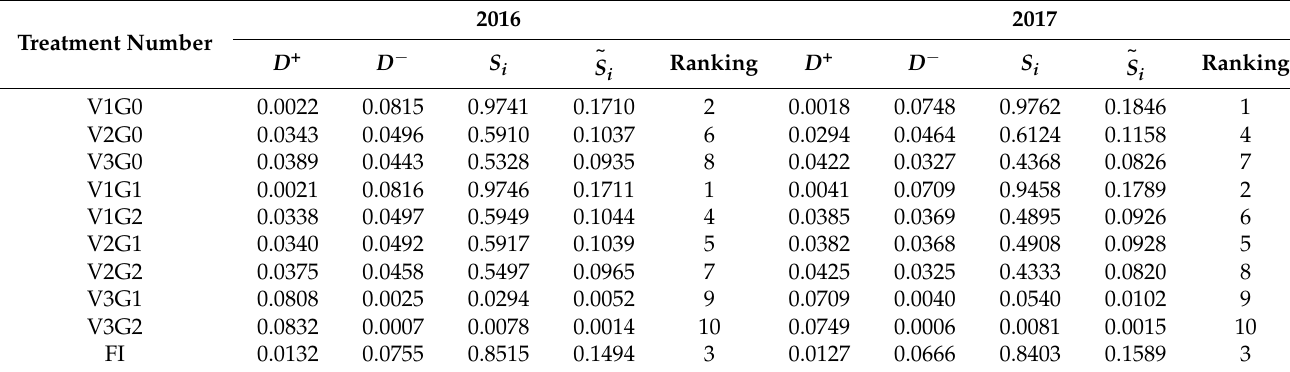
Table 9. Sequencing and calculation of the progress of each test